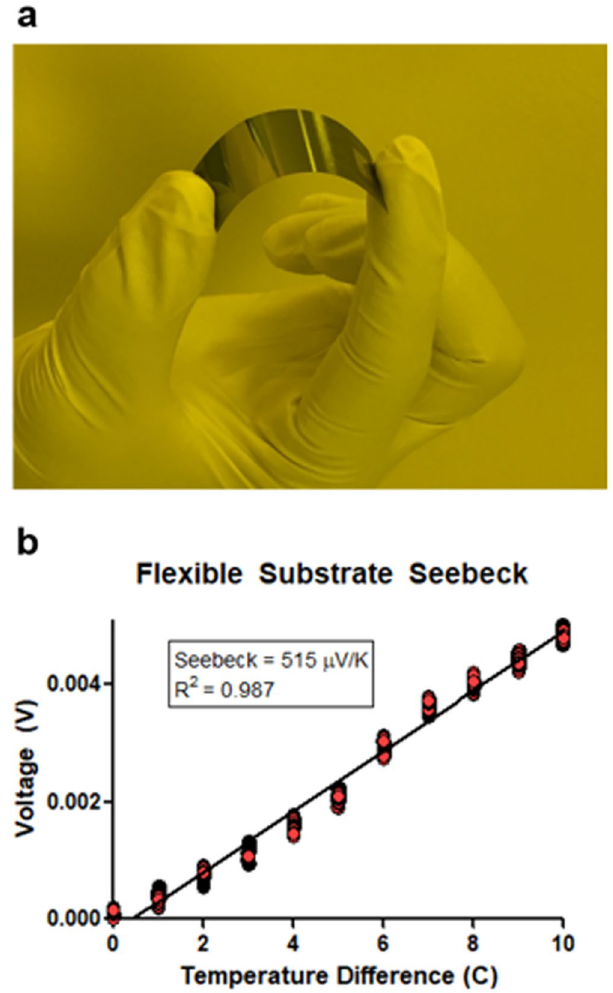
Figure 6. Flexible chrome-on-silicon thermocouple arrays with a high Seebeck coefficient fabricated on a 50 µ m-thick double-side-polished silicon wafer. ( a ) In bending testing, the flexible thermocouple array achieved a bending radius of 1.51 cm and a curvature angle of 64.98°. ( b ) Seebeck measurements of the flexible thermocouple array made on a flexible thin wafer – the measurements are highly linear with a high Seebeck